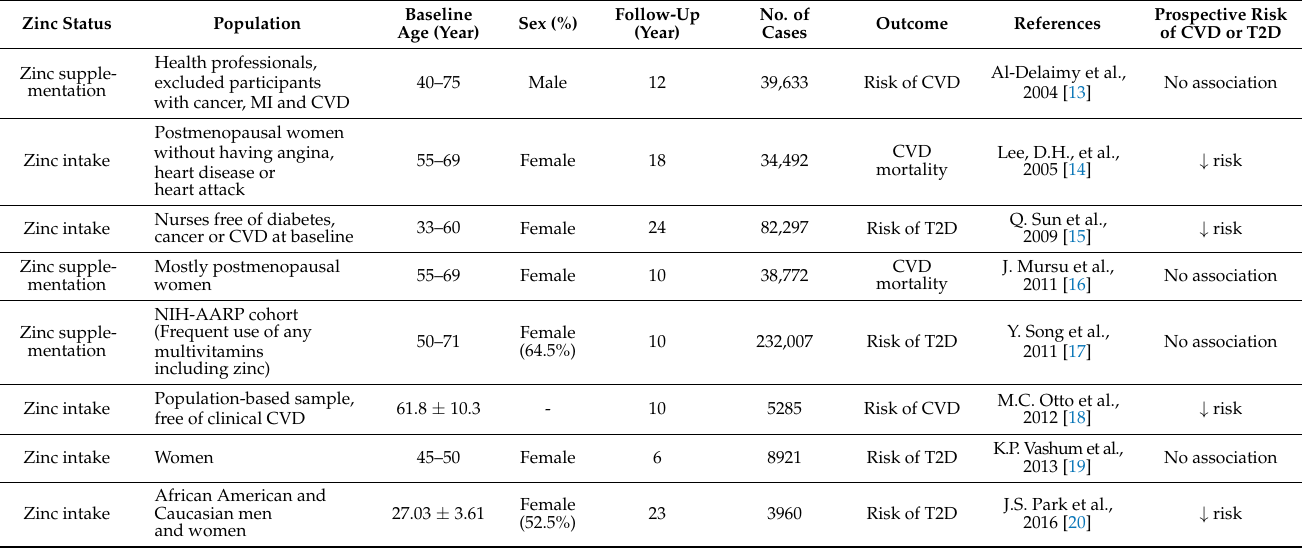
Table 1. Epidemiological studies of the effect of zinc intake on the risk of type2 diabetes and CVDs.